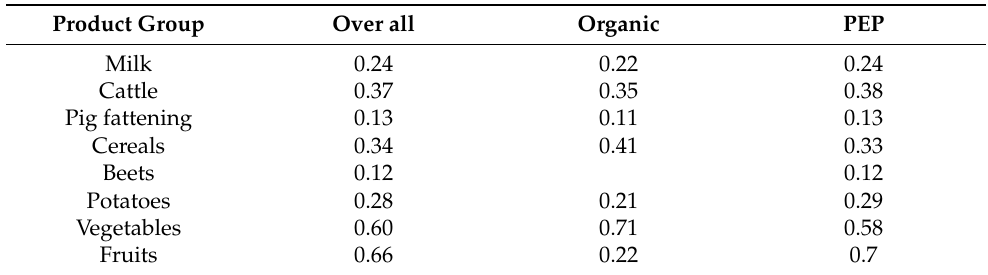
Table 3. Coefficient of variance of environmental efficiency for the product